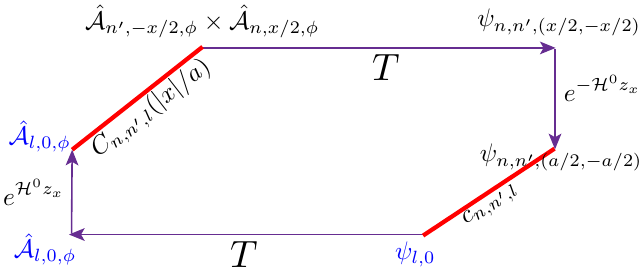
Figure 3: The procedure of extracting OPE between two local operators. Two local ˆ operators ˆ (cid:48) , − x / 2, φ and (cid:48) , x / 2, φ shown in the upper left corner undergo a series A n A n of transformations following the arrows in the clockwise direction : 1) the operators inserted to the IR fixed point corresponds to the ground state with two local excita- tions through the action-state correspondence (right arrow T ); 2) the state is evolved = ln | x | (down arrow e − H 0 z ); 3) the resulting state with the RG Hamiltonian for z x a supports local excitation near the origin which is then expressed as a linear superpo- sition of the eigenstates ψ with local excitations at the origin weighted with c l ,0 4) the resulting state corresponds to the fixed point with local operator insertions at the origin (left arrow T ); 5) the theory is evolved backward in RG time by − z arrow e H 0 z ). The identification of the final operator with the initial product of two operators gives the desired operator product